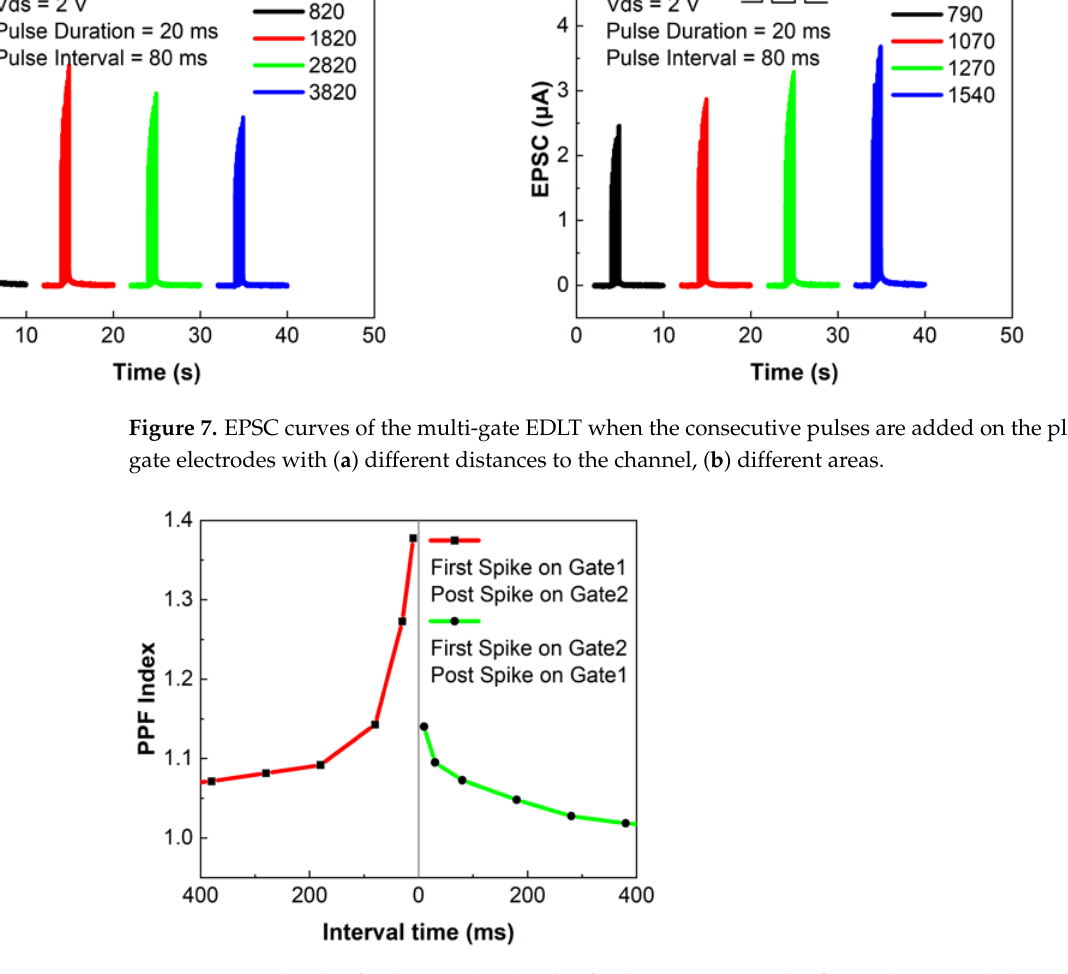
Figure 8. Paired-pulse facilitation (PPF) index for the cases where the first pulse is applied on Gate1 and the second pulse is applied on Gate2, as well as its